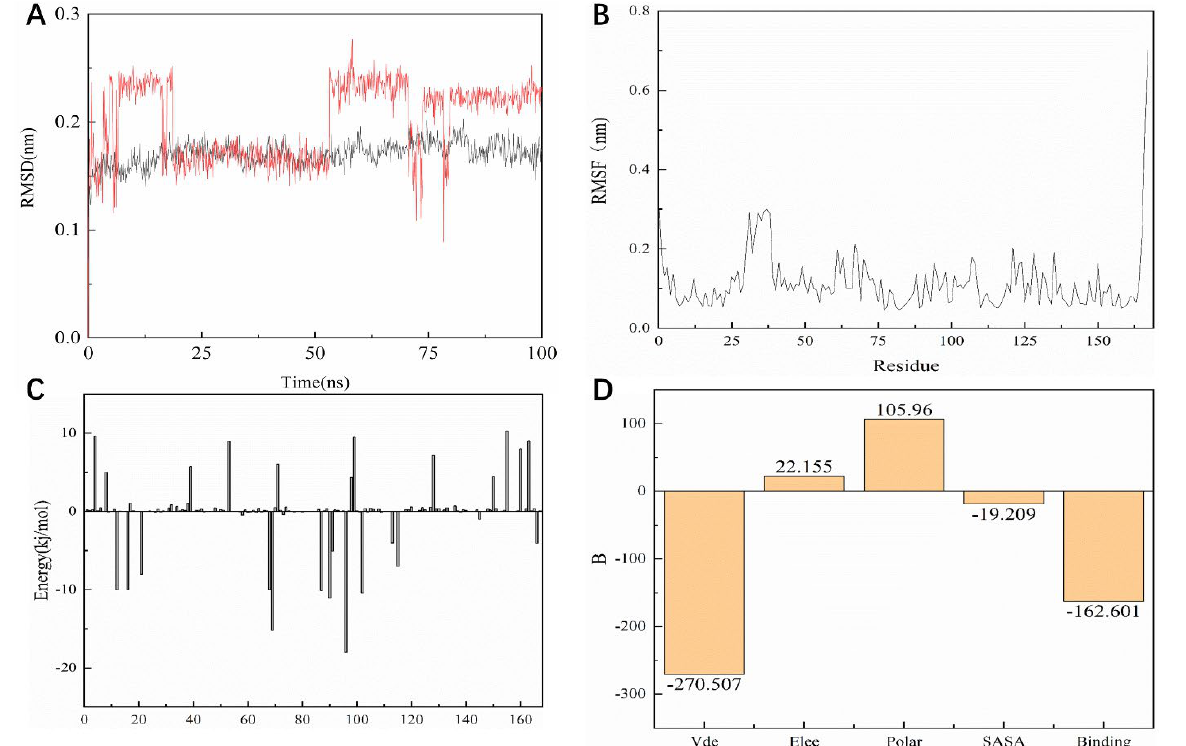
Figure 11. Dynamic simulation results. ( A ) RMSD values extracted from protein fit ligand of the protein-ligand docked complexes and ligand. RMSD plot of the KRAS G12C complex (red) and ligand 14 (black). ( B ) The RMSF graph of all complexes along with protein during 100 ns MD simulation. RMSF plot of the KRAS G12C complex (black). ( C ) Residue-wise decomposition of binding free energies obtained from the MM-PBSA analyses. ( D ) Binding energy of binding for the protein complexed with ligand 14.